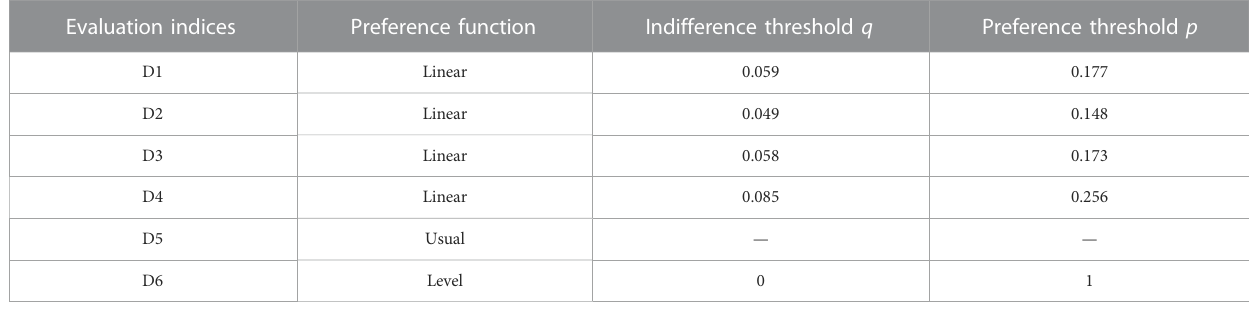
TABLE 8 Flow scores of site